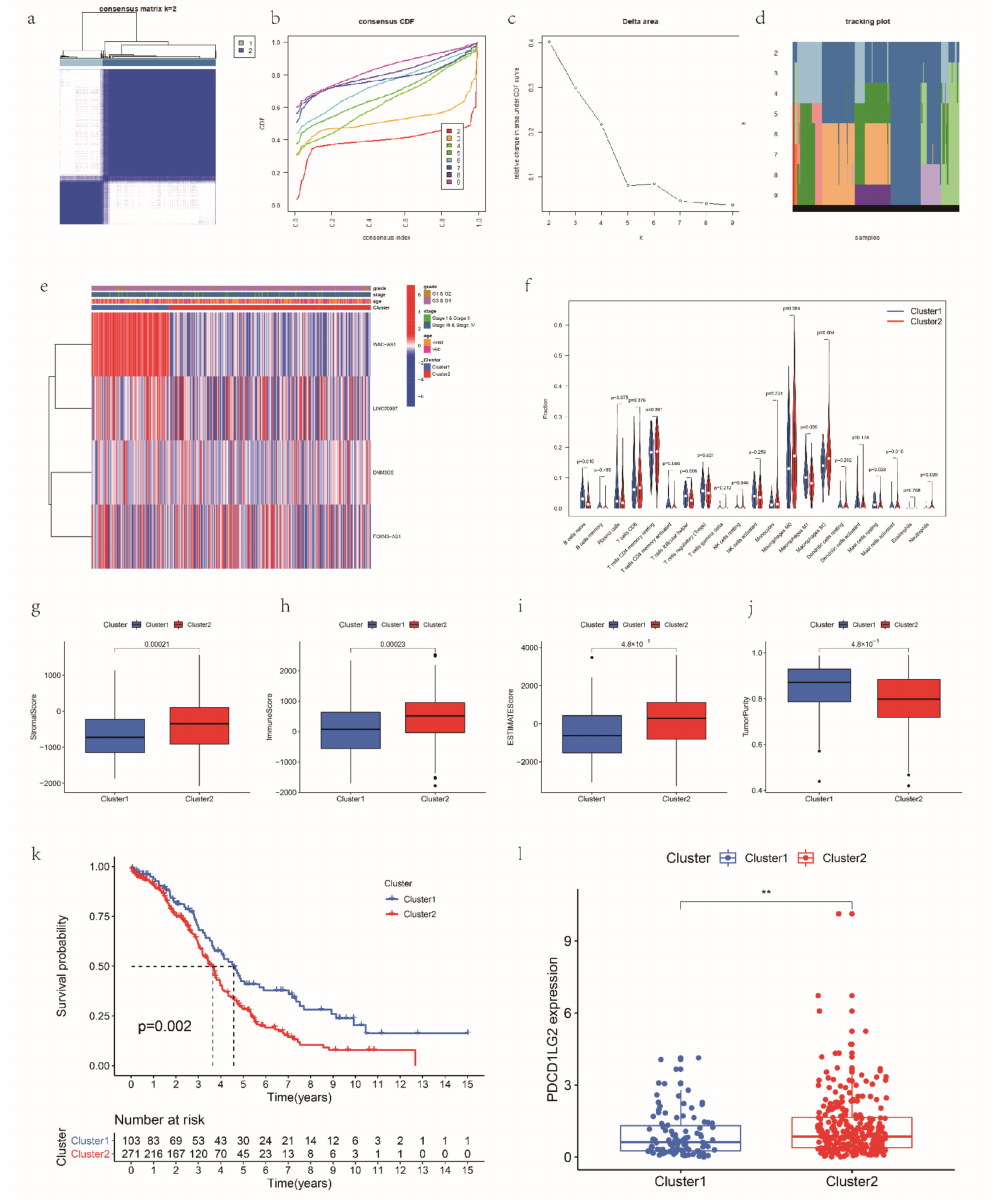
Figure 7. Prognosis and immune infiltrations in consensus clustering subgroups of OV. ( a ) Consensus clustering matrix for k = 2. ( b ) Consensus clustering cumulative distribution function (CDF) for k = 2 to 9. ( c ) Relative change in area under the CDF curve for k = 2 to 9. ( d ) Tracking plot for k = 2 to 9. ( e ) Expression pattern of the mRLs in Cluster 1 and Cluster 2 subgroups. ( f ) The abundance of 21 immune cells in Cluster 1 and Cluster 2 subgroups. ( g – j ) Stroma, immune and ESTIMATE scores and tumor purity in Cluster 1 and Cluster 2 subgroups. ( k ) Kaplan–Meier analysis of patients in Cluster 1 and Cluster 2 subgroups. ( l ) The expression of PD-L2 in Cluster 1 and Cluster 2 subgroups. ** p <